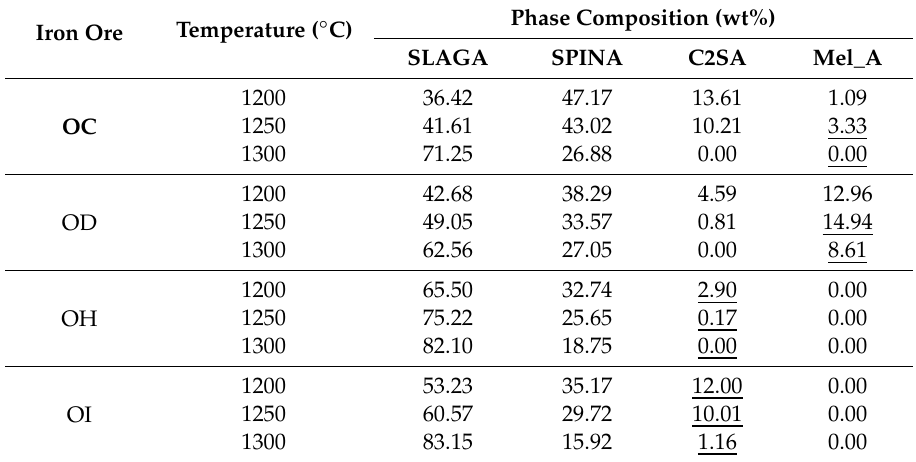
Figure 7. Liquid phase content under different sintering temperatures: ( a ) limonite, ( b ) hematite and goethite mixed ore, ( c ) hematite and ( d ) magnetite. Table 4. Thermodynamic equilibrium calculations for OC, OD, OH and OI.